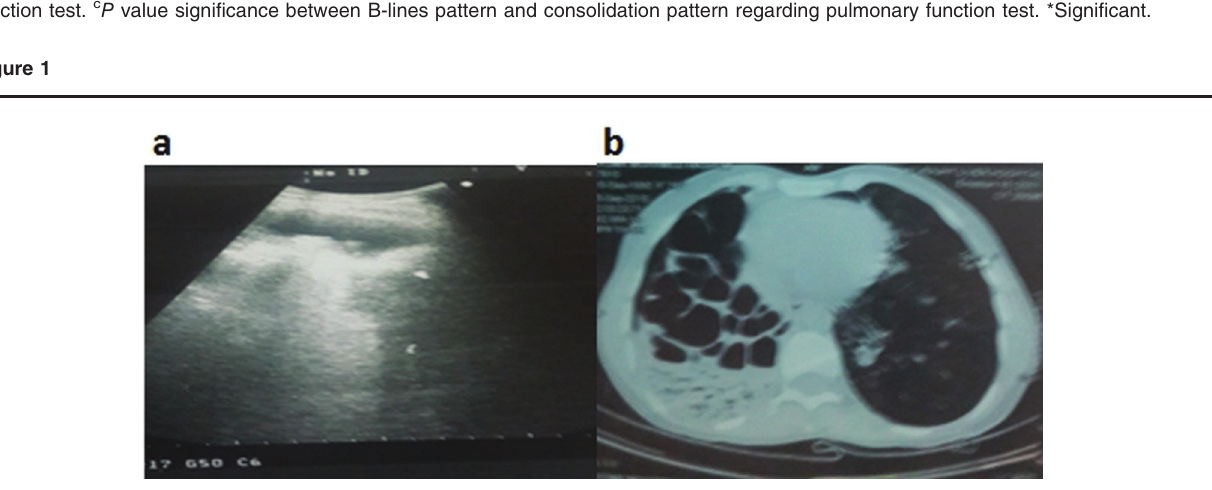
(a) Lung ultrasound showing the pattern of consolidation in the right infrascapular region. (b) High-resolution computed tomography (HRCT) of the chest showing severe unilateral cystic bronchiectasis, some with air-fluid levels affecting the right middle and lower